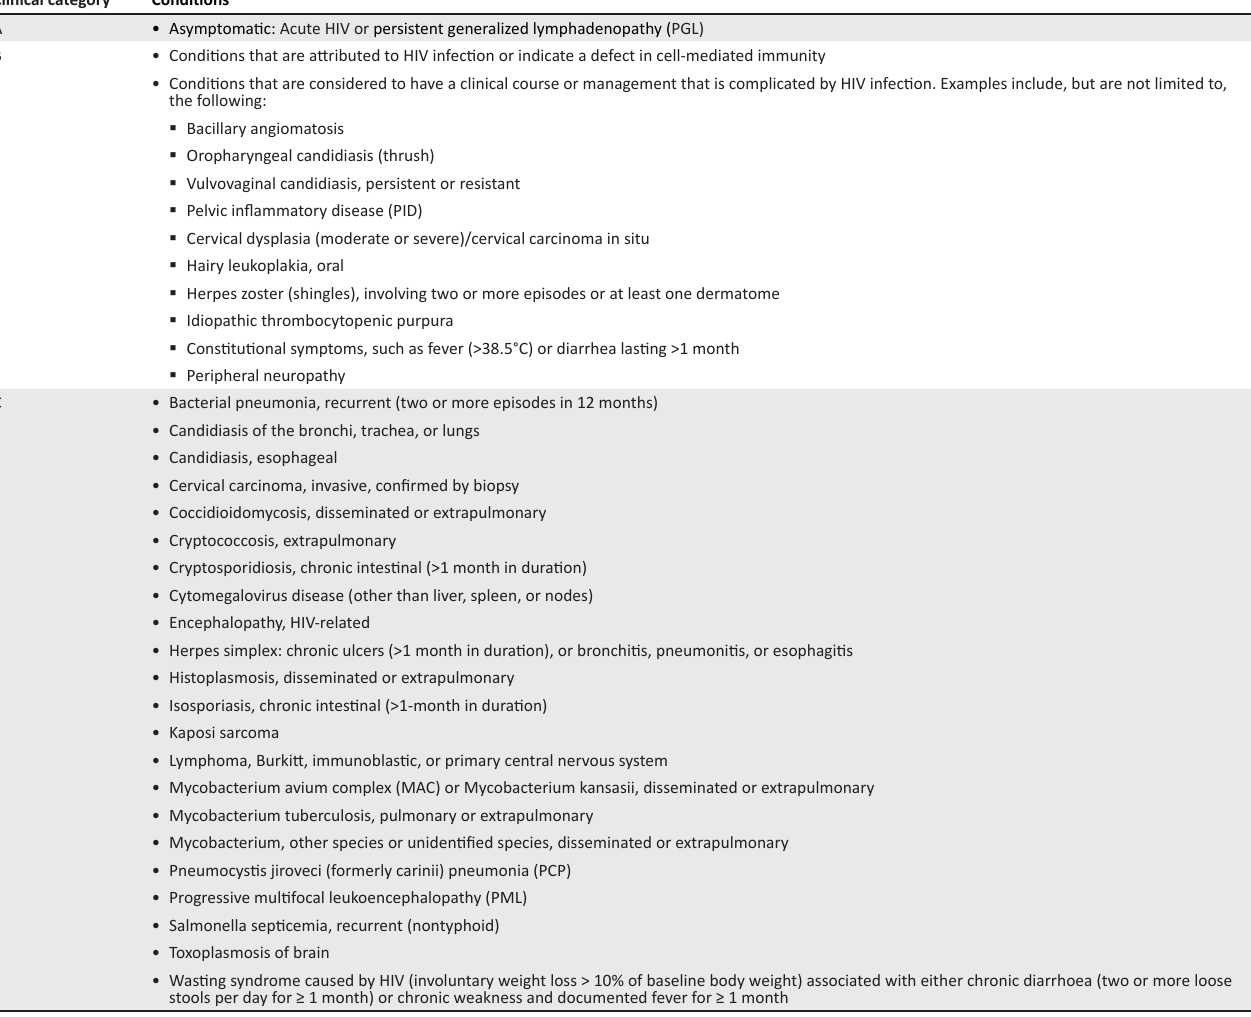
TABLE 1-A1: CDC classification system for HIV-infected adults and adolescents.